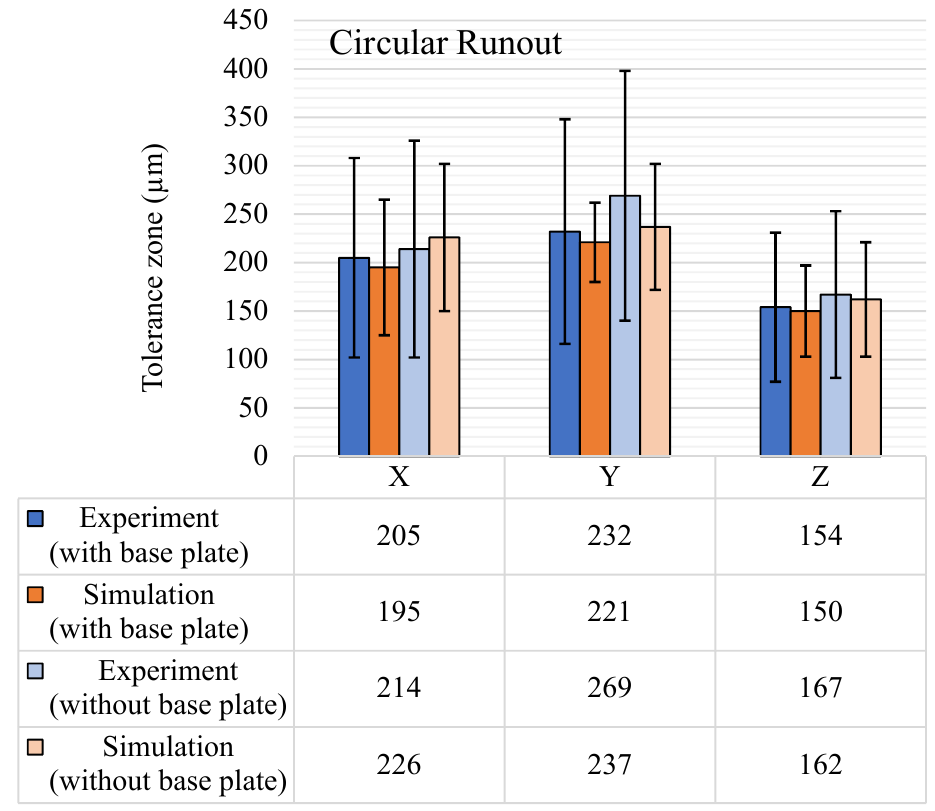
Figure 19. Circular runout (µm) tolerance results, with and without the base plate.